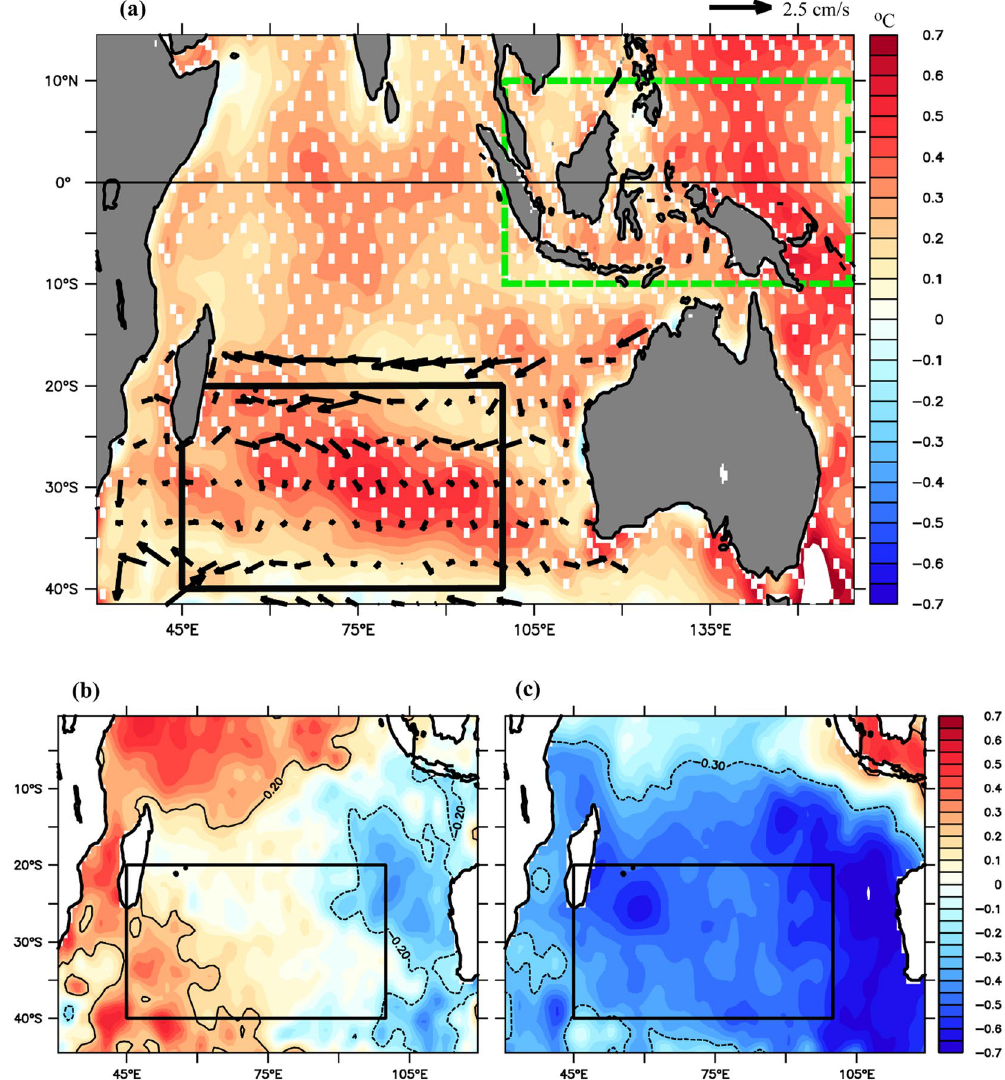
Figure 3. ( a ) SST difference between the GWH (1998–2016) and preGWH (1981–1997) overlaid with the current anomaly (GWH-PreGWH) of upper 100 m. White dots represent the SST anomaly above 90% significance level ( b ), Correlation between MH intensity and SST during the preGWH and ( c ), Correlation between MH intensity and SST during the GWH. The dashed/solid contour indicates 90% significance level. The black rectangle in ( a – c ) represent the MH region, and the dashed green rectangle in ( a ) represents the western Pacific